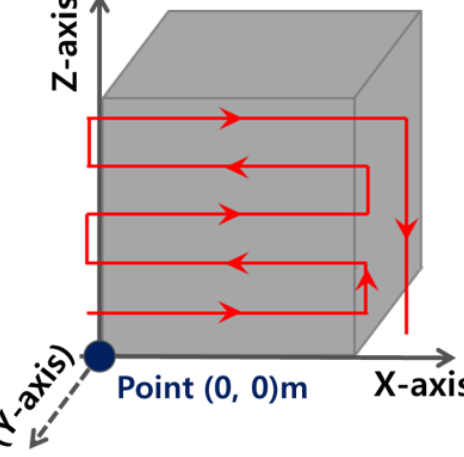
Figure 6. Battery Utilization optimized routing coordinate.